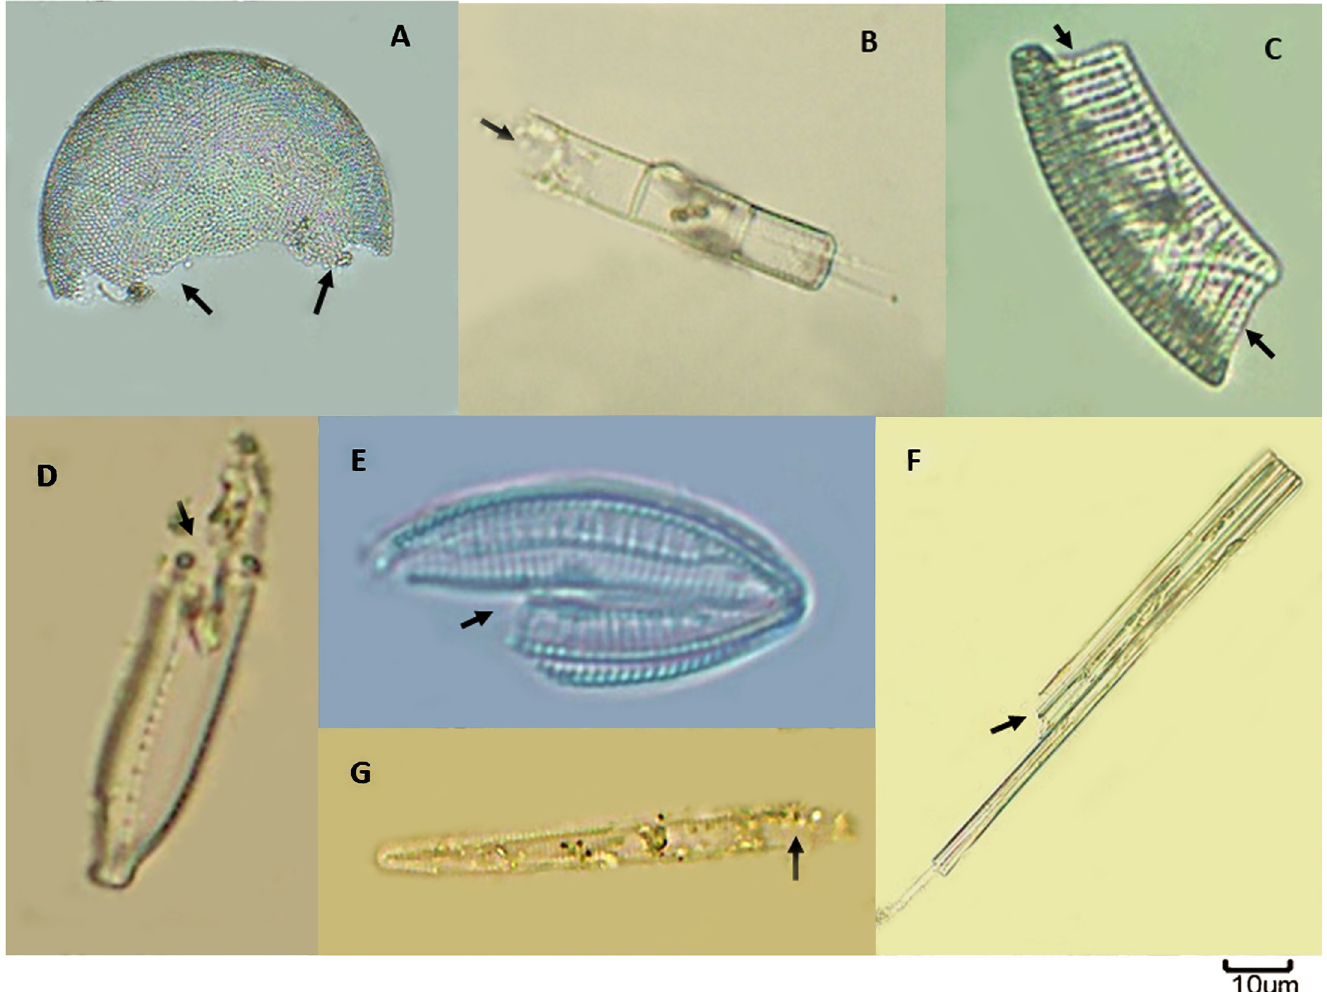
Fig 5. Broken phytoplankton cells. A- Coscinodiscus sp.; B- Aulacoseira sp.; C- Epithemia sp.; D- Hantzschia spp.; E- Mastogloia sp.; F- Fragilaria sp.; G- Synedra sp. The broken parts are indicated by arrow